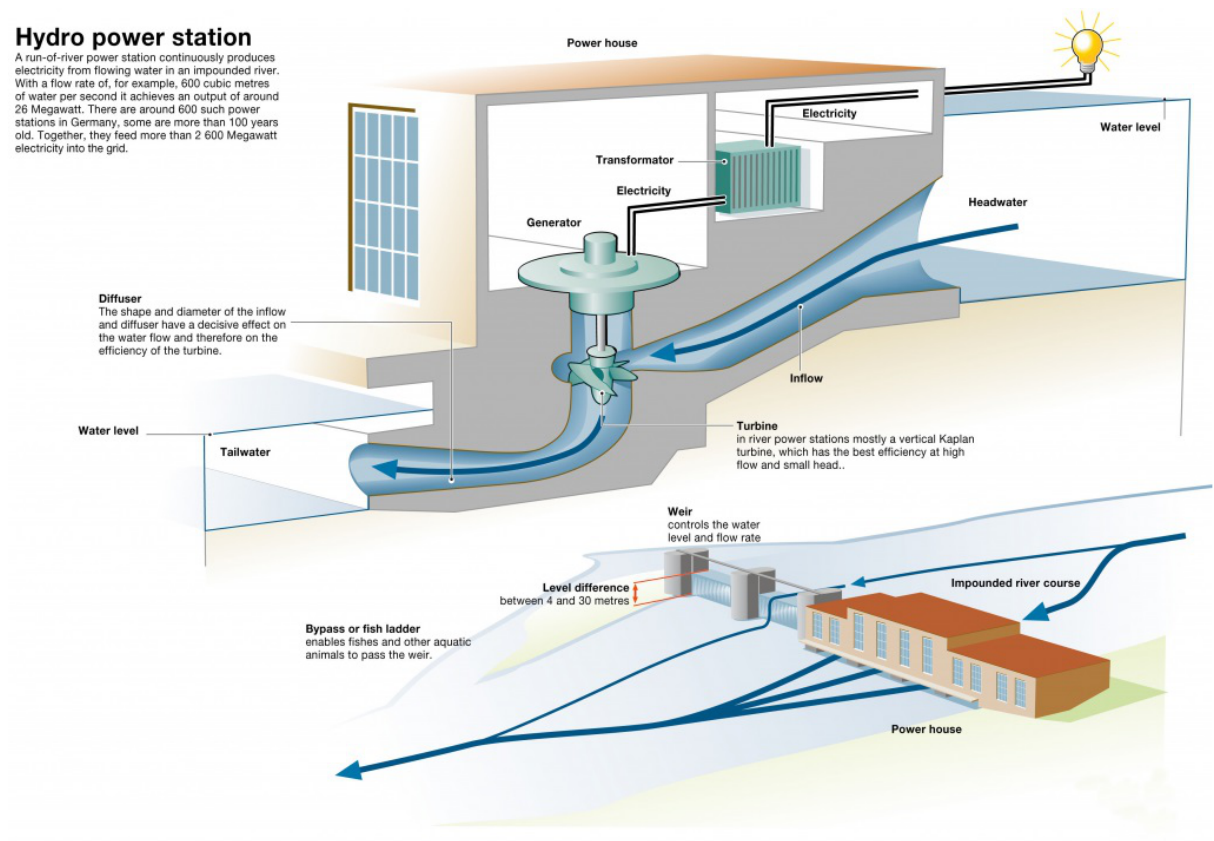
Figure 1: Run-of-river power plant (Image courtesy of Commercial Renewable Energy Ltd.). 2